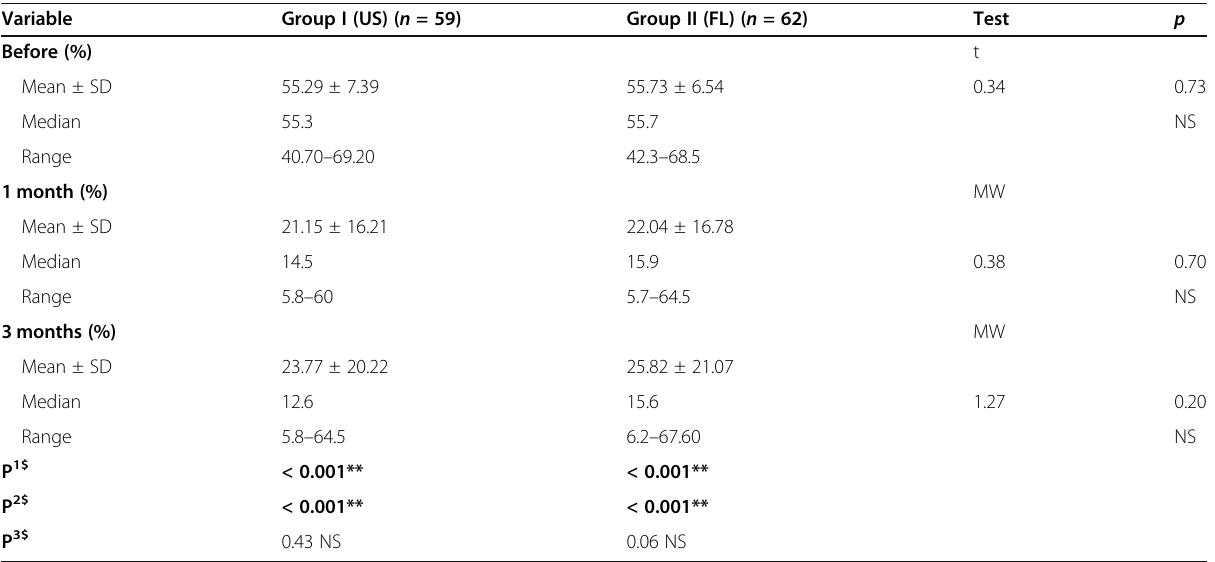
Table 5 Oswestry Disability Index of the two studied groups